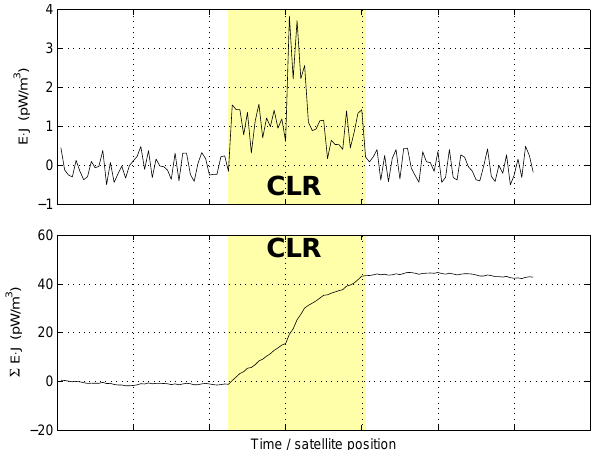
Fig. 1. Schematic CLR showing typical quantities discussed in this article. Top panel: power density measured by the satellites. Bot- tom panel: power density integrated over time along the spacecraft path. The CLR corresponds to the region of large E · J > 0 and the clear step in the integrated power density. The behaviour of a CGR is similar, but in this case the power density and step are